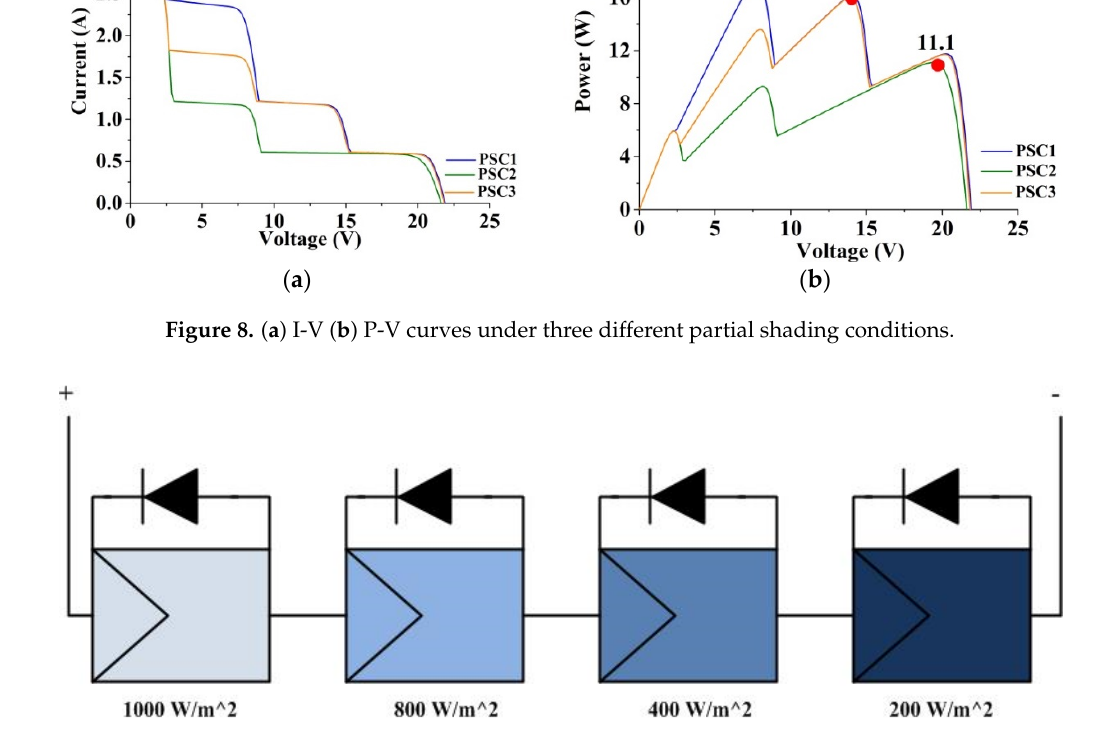
Figure 9. Non-uniform irradiance penetrated into the PV modules. Table 4. Detailed profiles of STC and PSCs.